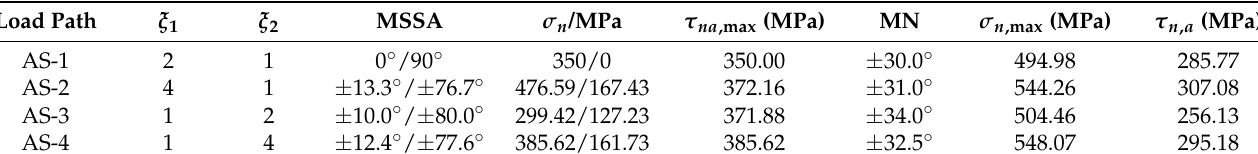
Table 4. MSSA and MN plane orientations under different frequency ratios.